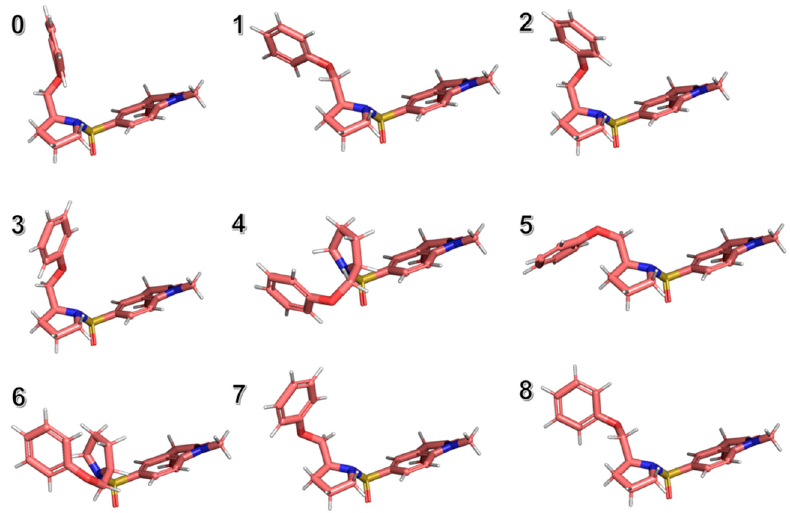
Figure 3. The top 9 significant ligand’s conformations for the ligand in its free solution phase with respect to the 1gfw caspase-3-Inhibitor complex (from conformer 0 to conformer 9), generated by using the MT protocol.